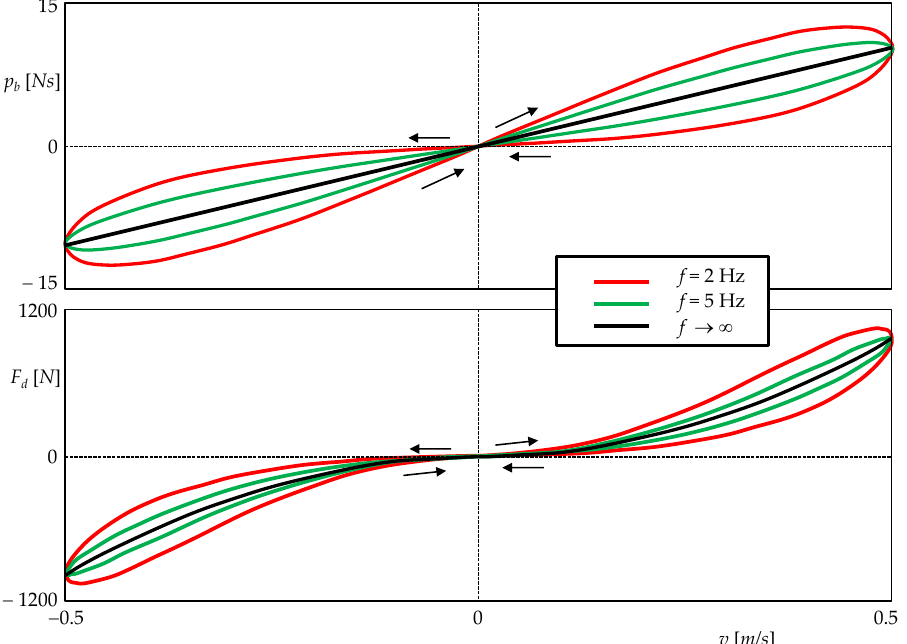
Figure 5. Hysteresis loops accompanying the phenomena of inertance ( top ) and viscous friction ( bottom ). Both loops are of type I, i.e., with a crossing at the origin. As the frequency increases, the hysteresis gradually disappears, and the loops turn into unambiguous curves.